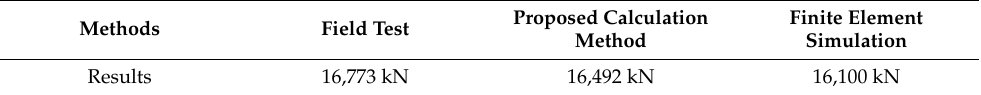
Figure 8. Load–Displacement simulation curves of piles with R inter ,1 and R inter ,2 . Table 5. Vertical bearing capacity of SDRN pile by field test, theory calculation, and